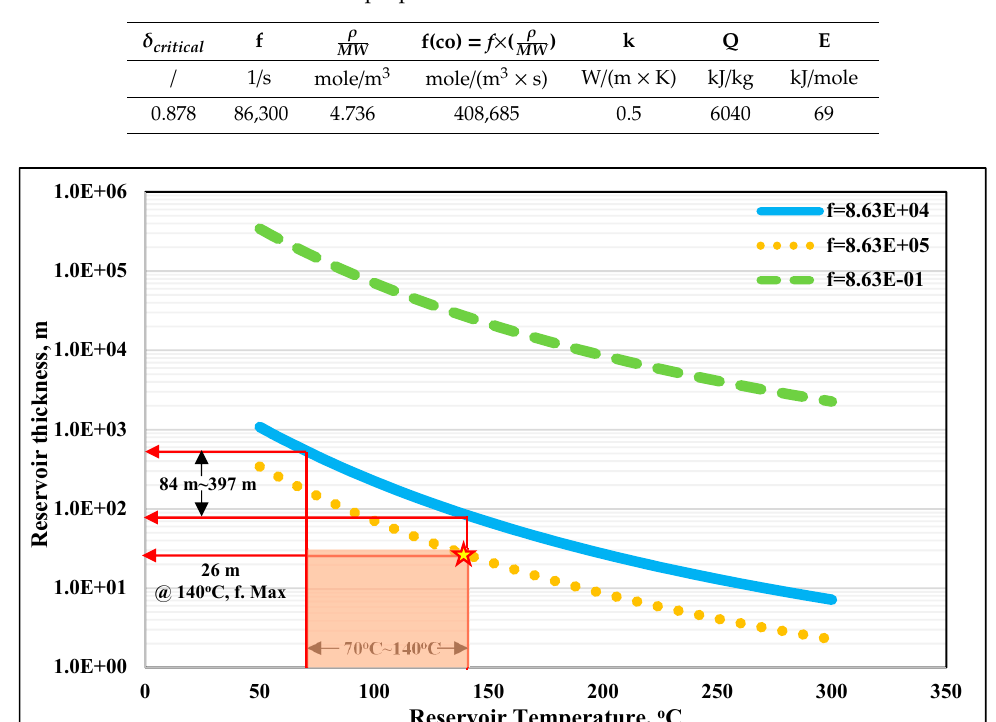
Figure 5. The spontaneous ignition screening criteria for the tested mixture of oil and sand.